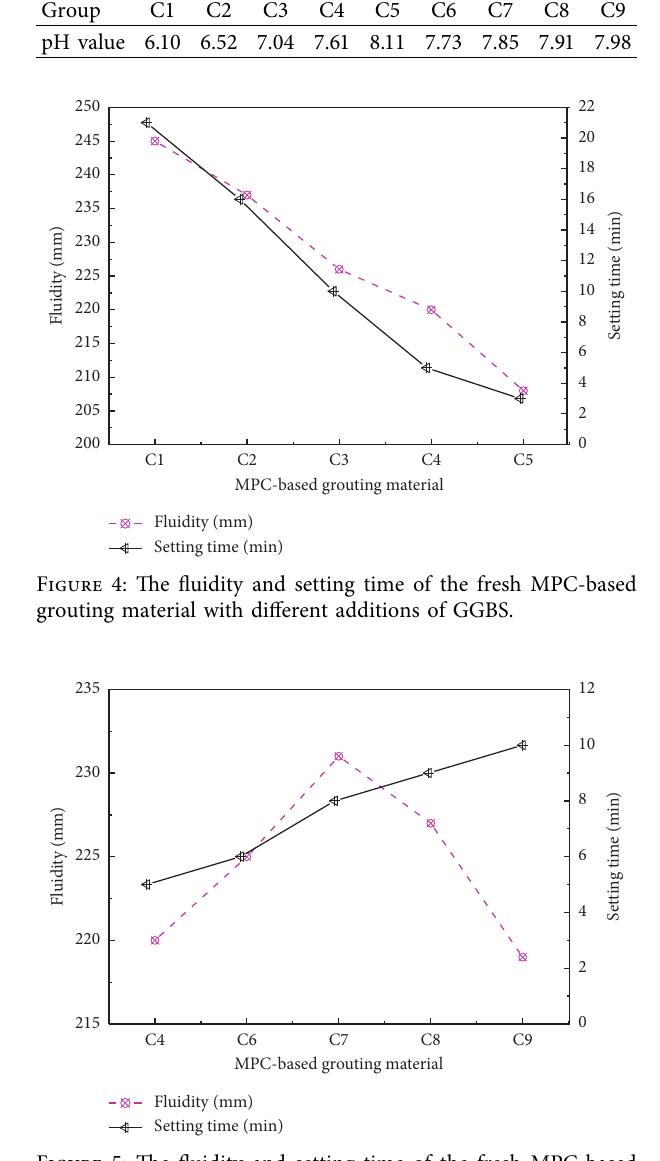
Table 3: The pH value of the fresh MPC-based grouting material. Group